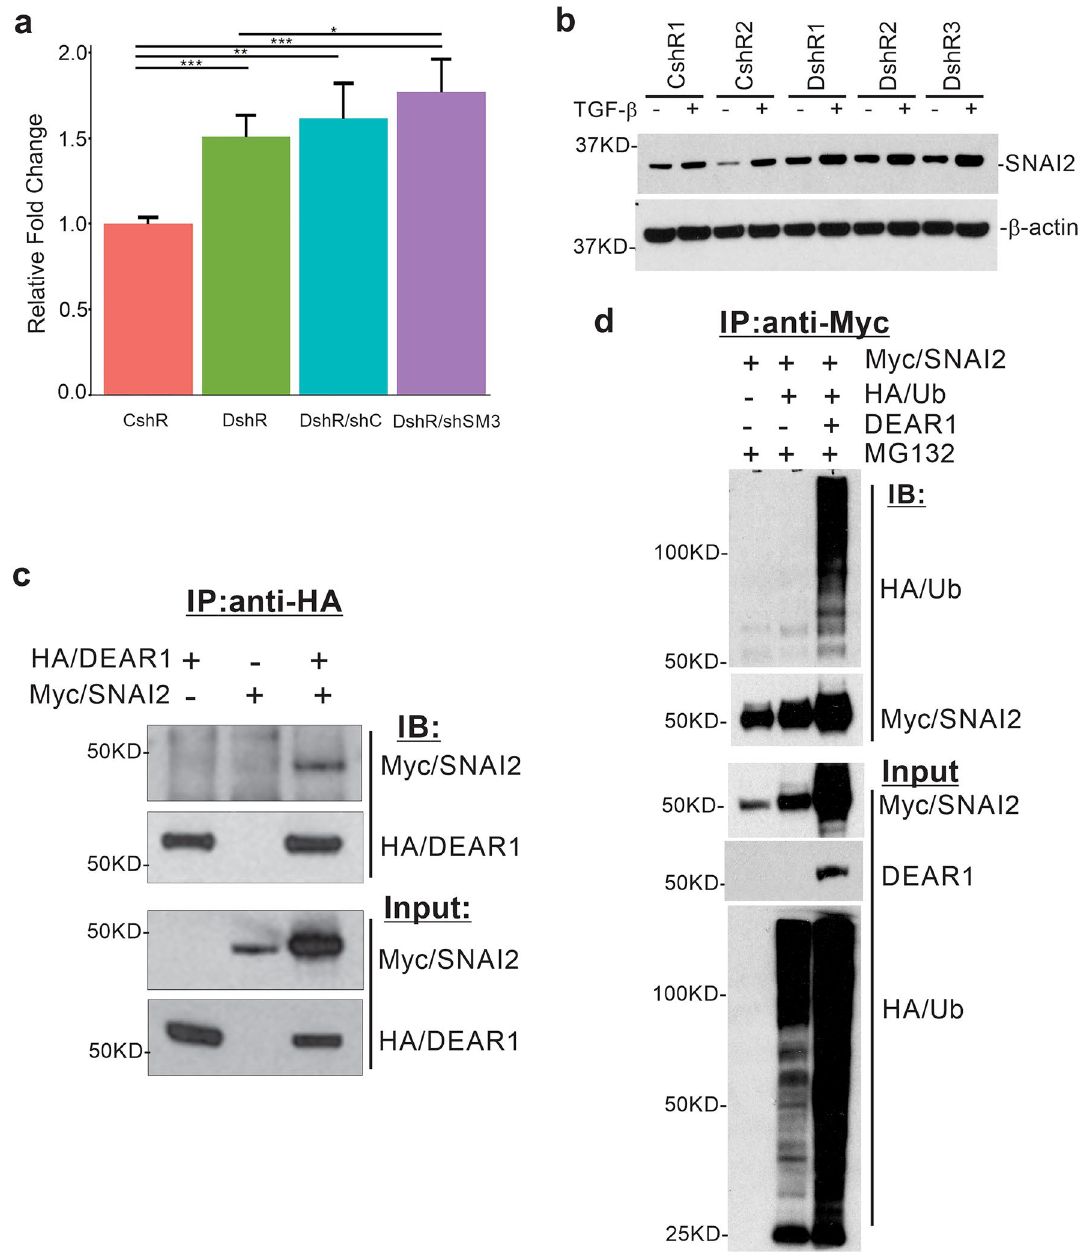
Figure 4. The regulation of SNAI2 by DEAR1. ( a ) Bar plots of qPCR results (mean ± SD) of SNAI2 mRNA levels in control (CshR), DEAR1 -KD (DshR), DEAR1 -KD/shRCt clone (DshR/shC), and DEAR1-SMAD3 double KD (DshR-shSM3) across 2 runs. P-values were calculated using Wilcoxon Rank Sum tests. *p < 0.05– 0.1, **p < 0.01, ***p < 0.001. The barplots were created using RStudio (Version 1.0.143), https:// www. rstud io. com. ( b ) Western blot showing SNAI2 protein expression in control (CshR) and DEAR1 -KD clones (DshR) with and without TGF-β treatment. Full length gels for Western blots are shown in Supplementary Fig. S2. ( c ) Co-immunoprecipitation (Co-IP) to determine possible interaction between DEAR1 and SNAI2. HEK293T cells were co-transfected with an HA - DEAR1 -expressing plasmid and/or a Myc-SNAI2 expression plasmid. After 24 h post-transfection, cell lysates were immunoprecipitated with anti-HA (rabbit) antibody. SNAI2 proteins were blotted with anti-Myc (mouse) antibody. Full length gels for Western blots are shown in Supplementary Fig. S3. ( d ) Co-IP assay to detect ubiquitination of SNAI2 by DEAR1. HEK293T cells were co-transfected with Myc-SNAI2 , HA - ubiquitin , and DEAR1 . Cells were lysed 48 h post-transfection. Lysates were denatured and immunoprecipitated with anti-Myc (mouse) antibody. Ubiquitin was blotted with anti-HA (Rat) antibody. Full length gels for Western blots are shown in Supplementary Fig.